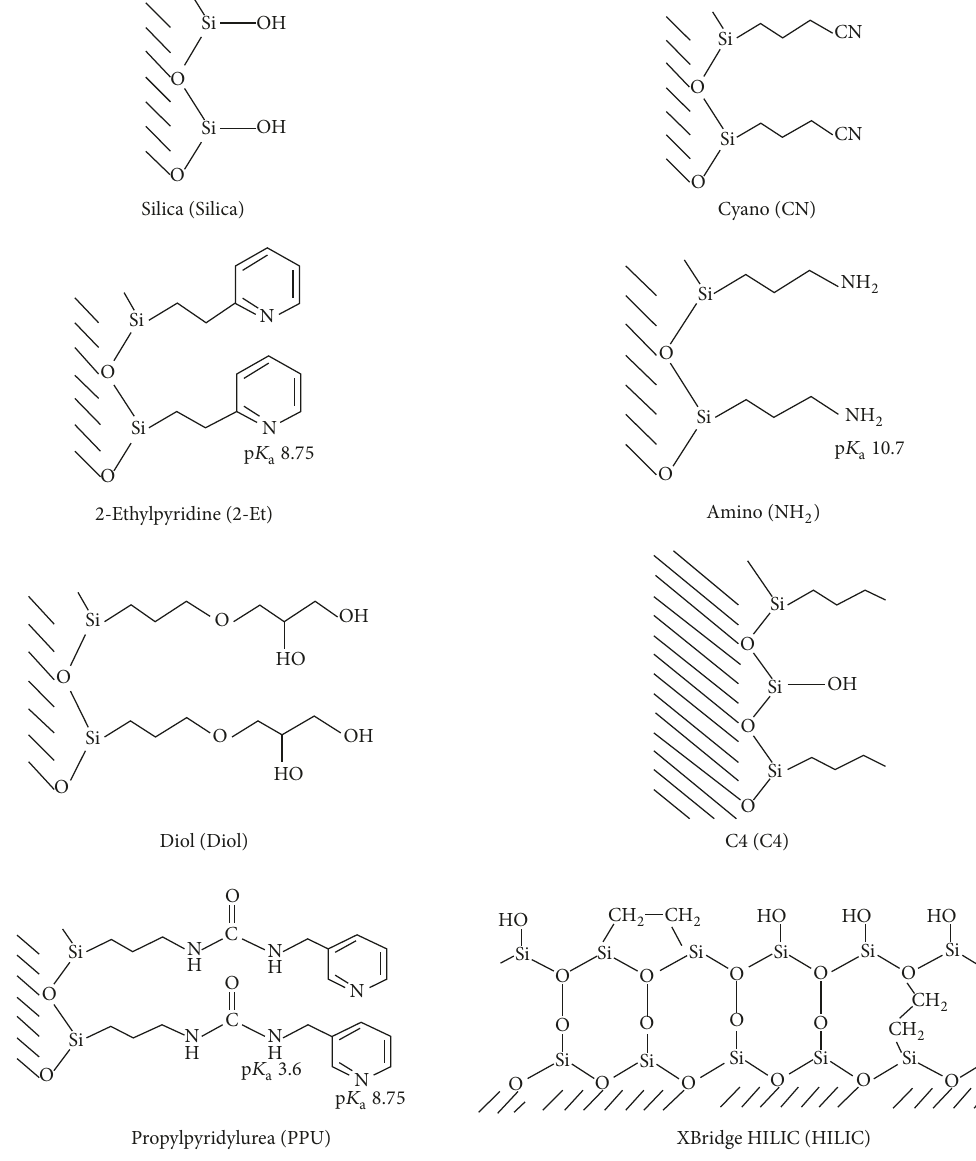
Figure 1: Structures of the eight tested stationary